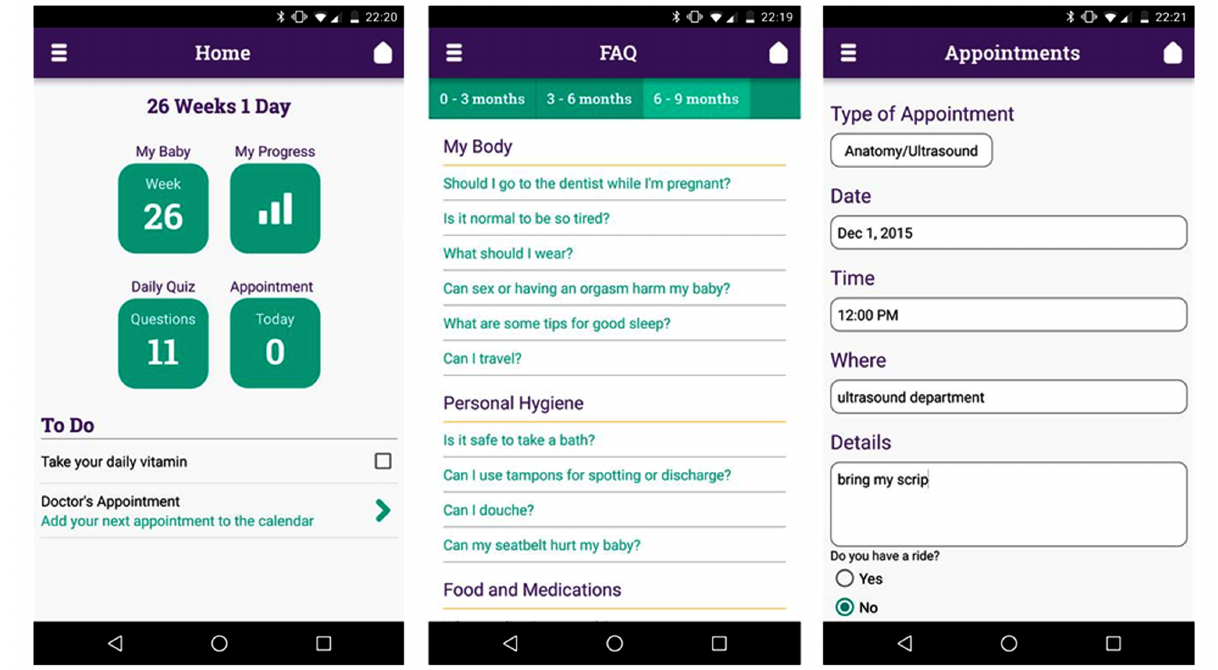
Figure 1. Sample screenshots taken from MHP, which was evaluated in proof-of-concept pilot with 16 women. From left: (1) Home screen, (2) frequently asked questions, and (3) appointment scheduling